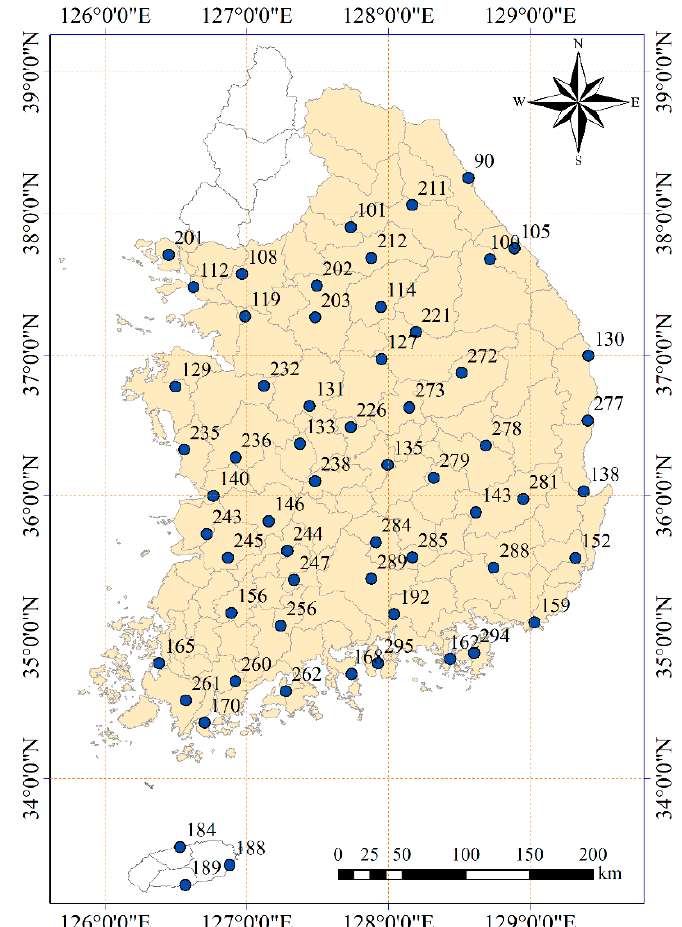
Figure 1. Study area and 60 automated synoptic observing system (ASOS) locations. The colored area denotes 109 mid-size watersheds, which are separated by a gray line border. The circle represents the 60 ASOS locations, and the number next to the circle represents ASOS ID.